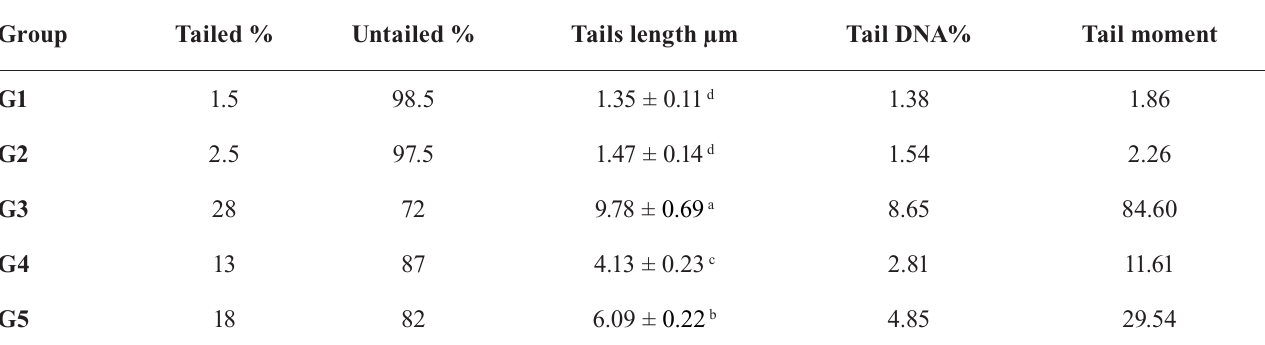
TABLE II - Comet assay parameters obtained by image analysis in hepatic cells of all groups after prevention experiment